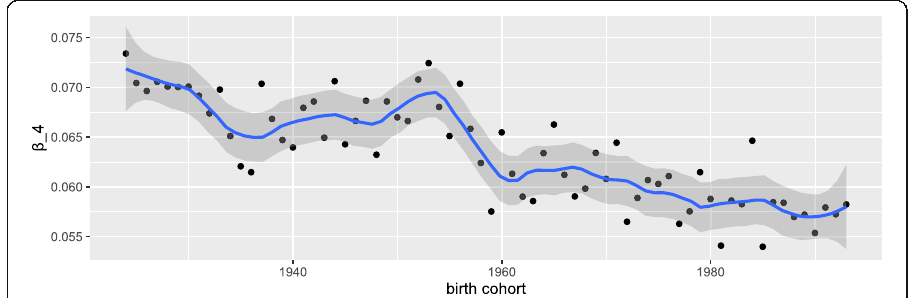
Fig. 5 Yearly variation in the effect of parents ’ occupational status (ISEI) on respondents ’ years of education